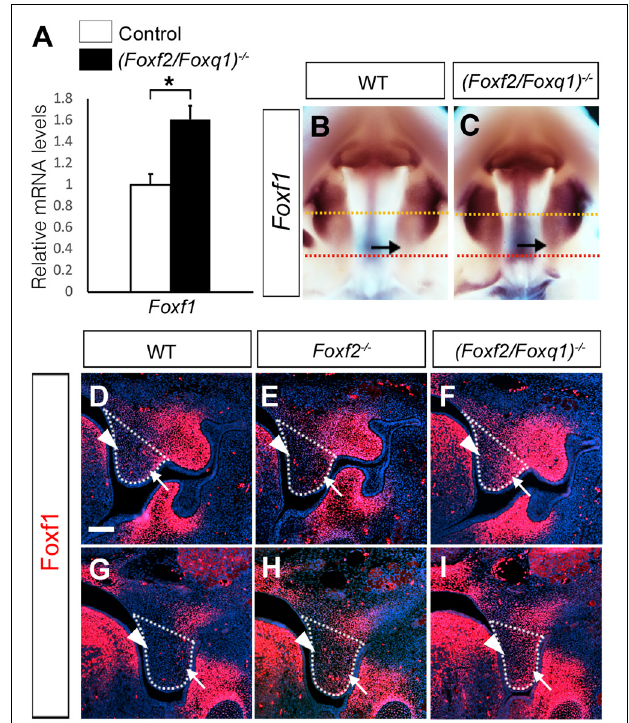
FIGURE 7 | Analysis of expression of Foxf1 in the developing palatal shelves. (A) Real time RT-qPCR analysis of the levels of expression of Foxf1 mRNAs in E13.5 palatal shelves in control and (Foxf2/Foxq1) − / − embryos ( n = 7). * p < 0.05. (B,C) Comparison of patterns of expression of Foxf1 mRNAs in E13.5 wild-type (WT) (B) and (Foxf2/Foxq1) − / − (C) mutant embryos. Note that the expression of Foxf1 mRNAs (detected in purple color) was extended to the posterior region of the palatal shelves in the (Foxf2/Foxq1) − / − embryos. Arrow points to the posterior region of the palatal shelves. Yellow dashed line marks the approximate position of the plain of frontal sections of different embryos shown in panels (D–F) , whereas red dashed line indicates the approximate position of the plain of frontal sections of different embryos shown in panels (G–I) . (D–I) Immunofluorescent staining showing Foxf1 protein (red) on comparable frontal sections from the middle (D–F) and posterior (G–I) regions of the palatal shelves in E13.5 wildtype (WT) (D,G) , Foxf2 − / − (E,H) , and (Foxf2/Foxq1) − / − (F,I) embryos. The palatal shelf was outlined with white dashed lines. Arrow points to the lateral side whereas arrowhead points to the medial side of the palatal shelves. Scale bar, 100 µ